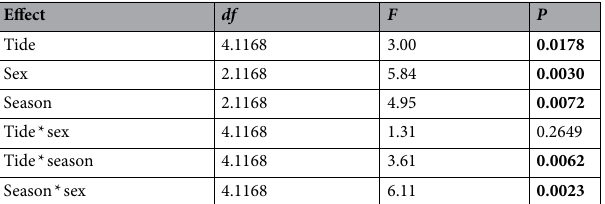
Table 2. Effects of tide, sex and season on activity of sea snakes ( Emydocephalus annulatus ). Three activity categories (inactive, foraging, and reproductive) were used as a three-factor multinomial dependent variable in a mixed model with snake ID as a random effect. Figures 3 and 4 show the probabilities of different activity categories predicted from this model. Bold font indicates significant values ( P < 0.05).